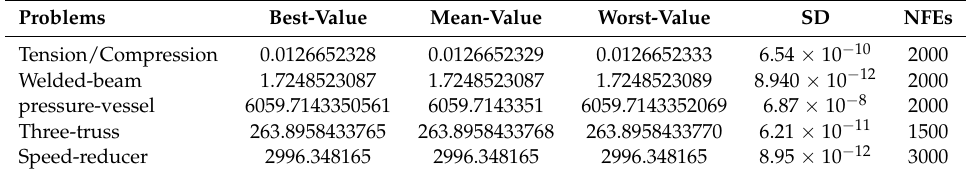
Table 10. Statistical outcomes achieved by SRIFA for all five engineering problems over 25 independent runs.